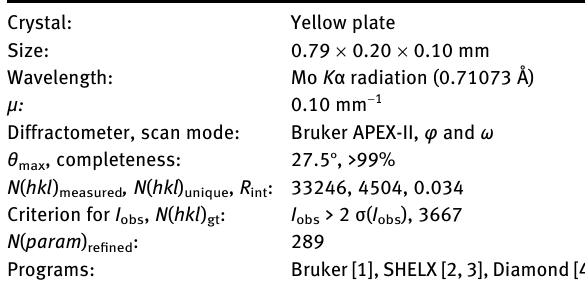
Table 1 contains crystallographic data and Table 2 con- tains the list of the atoms including atomic coordinates and displacement parameters.